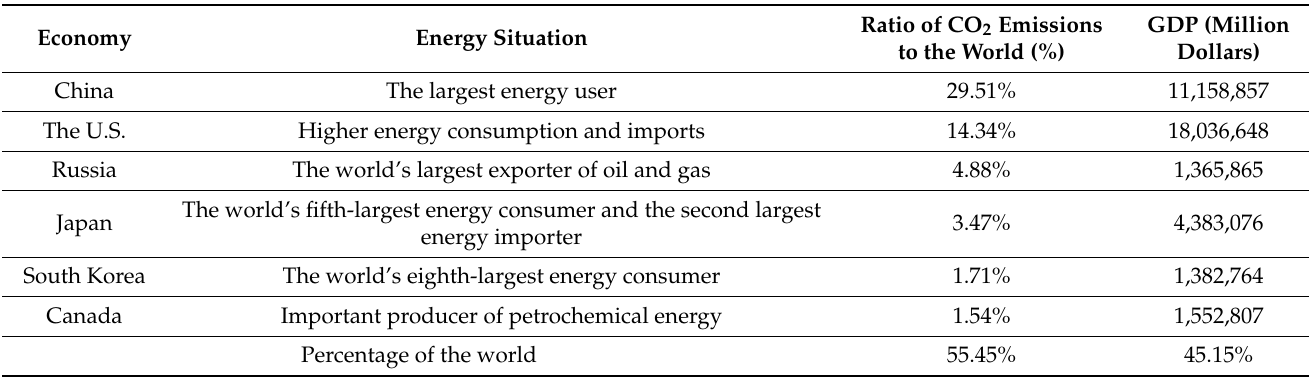
Table 2. Economies belonging to APEC with the highest carbon dioxide emissions in